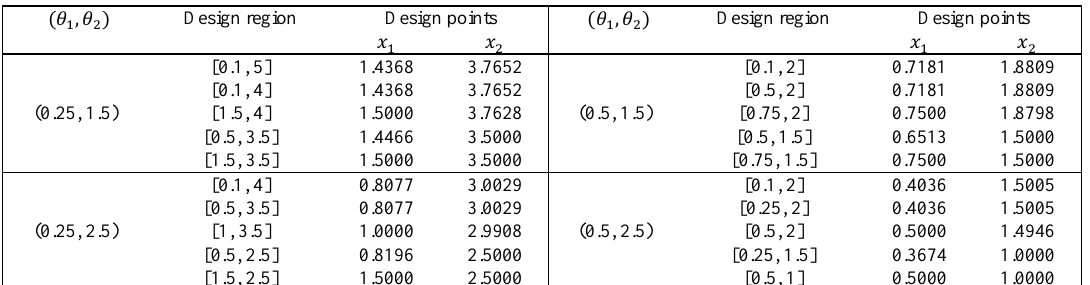
𝑤 = 0.35, 𝑤 = 0.65 1 2